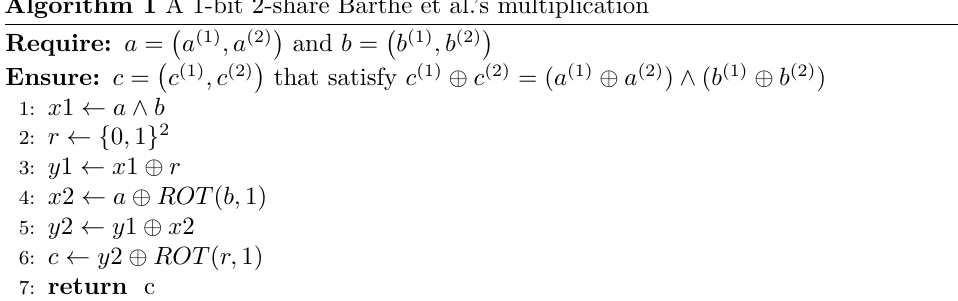
Algorithm 1 A 1-bit 2-share Barthe et al.’s